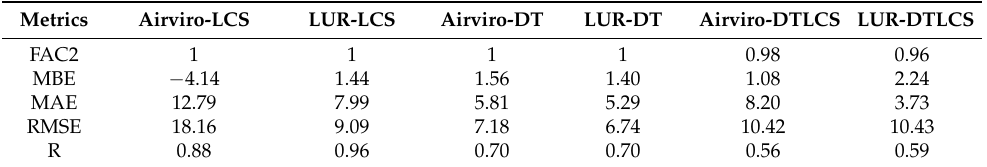
Table 2. Showing the values of different statistical metrics calculated by comparing fused and mea- sured NO 2 concentrations based on randomly selected testing dataset (train/test cross-validation). FAC2, MBE, MAE, RMSE and r stand for factor of two, mean biased error, mean absolute error, root mean squared error, and correlation